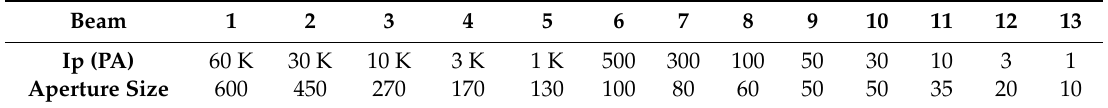
Table 3. Ion beam current range for